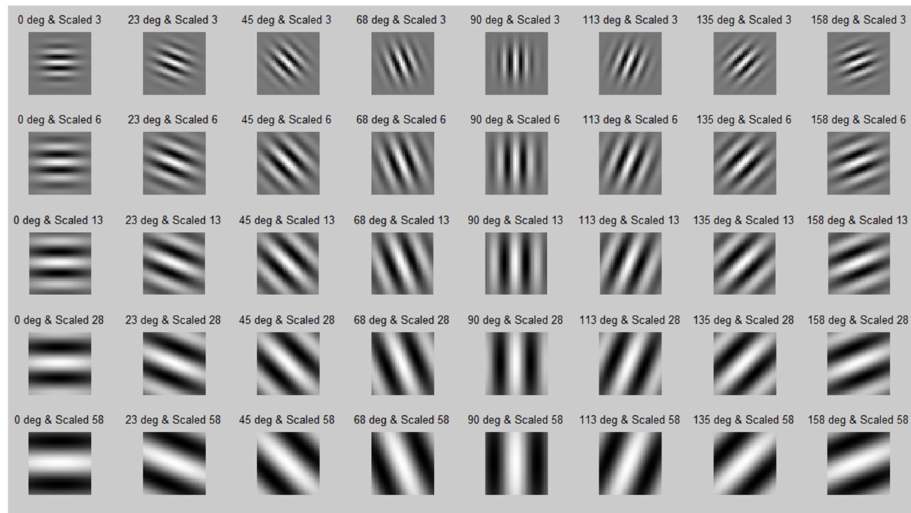
Figure 5. A two-dimensional Gabor filter with eight orientations and five scale [26].